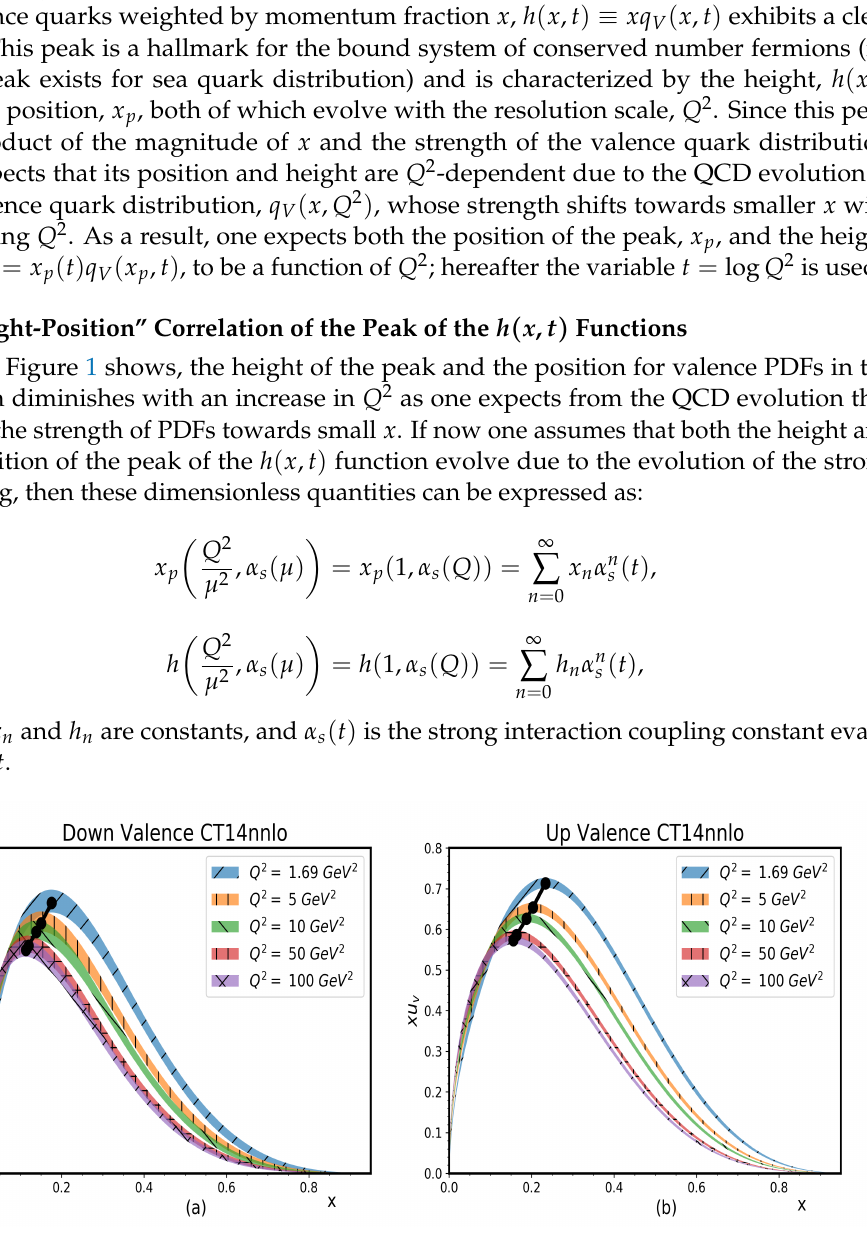
Figure 1. The momentum fraction x -dependence of the x -weighted distributions of the valence quarks, xq V ( x , t ) , at different values of the resolution scale Q 2 for down ( a ) and up ( b ) valence quarks in proton. Peaks at different Q 2 are connected by solid line to visualize the correlation between the position and the height of the peak. The shaded area is the Hessian error at 68% confidence